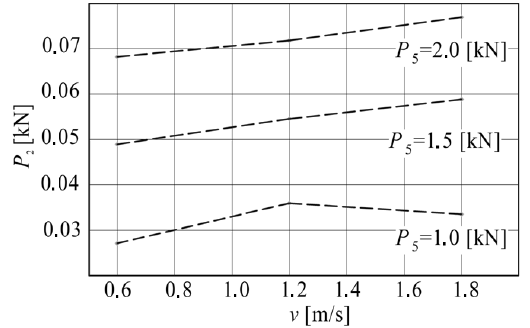
Figure 13. The dependence of the change in the tractive resistance P 2 of the balancing wheel on the working speed